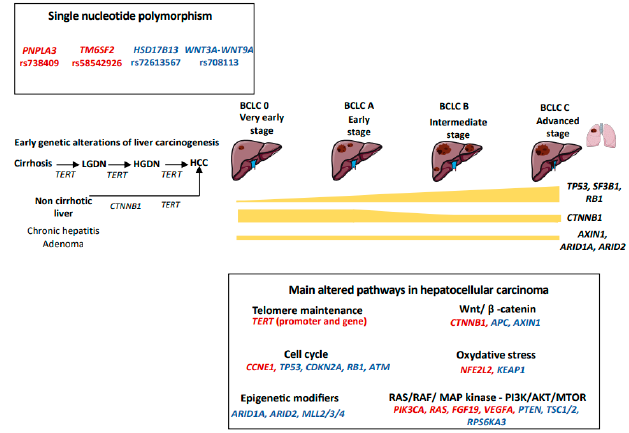
Figure 1. Genetic landscape of hepatocellular carcinoma. We figured the main somatic genetic driv ‐ ers observed in hepatocellular carcinoma, their frequencies across BCLC stages and the main sig ‐ naling pathways dysregulated. Activating mutations are reported in red, whereas inactivating mu ‐ tations are in blue. LGDN: low ‐ grade dysplastic nodule; HGDN: high ‐ grade dysplastic nodule; HCC: hepatocellular carcinoma. 2.1. Telomerase Maintenance The most frequently altered pathway in HCC is linked to telomerase reactivation [26]. Telomerase is a complex composed of telomerase reverse transcriptase (TERT), telomer ‐ ase RNA component (TERC) and various other proteins (e.g., TRF1, TRF2, TIN2, RAP1, TPP1, and POT1) that enables telomere synthesis [27]. This complex is physiologically suppressed in most cells of the adult body, including mature hepatocytes [28]. Preventing telomere shortening after cell divisions, telomerase reactivation favors cell immortaliza ‐ tion and the accumulation of genomic alterations that lead to carcinogenesis [29]. We have previously shown than aging, liver fibrosis, male sex and excessive alcohol consumption were the determinants of liver telomere attrition [30]. Particularly, cirrhosis was charac ‐ terized by the presence of short telomeres, underlying the need to reactivate telomerase in order to promote malignant transformation and proliferation [30]. Different mecha ‐ nisms of telomerase reactivation have been described in HCC: TERT promoter mutations, viral insertion (HBV or adeno ‐ associated virus type 2 (AAV2)) in the TERT promoter, TERT amplification and translocation [29]. In addition, the alternative lengthening of te ‐ lomeres mechanism has been described in a small subset of tumors [29,31]. Somatic TERT promoter mutations are the most frequent somatic mutations found in HCC (30 ‐ 60%), and in 95% of cases are represented by a C>T transition in the − 124bp hotspot [29] and co ‐ occur frequently with mutations in catenin beta 1 ( CTNNB1 ) [21]. To note, TERT promoter hotspot mutations are equally distributed across all Barcelona Clinic Liver Classification